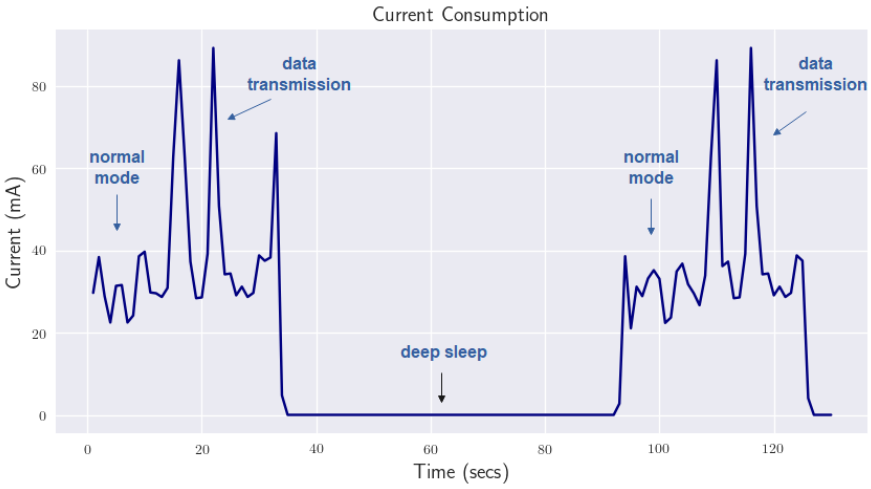
Figure 9. Current consumption of the smart tag.